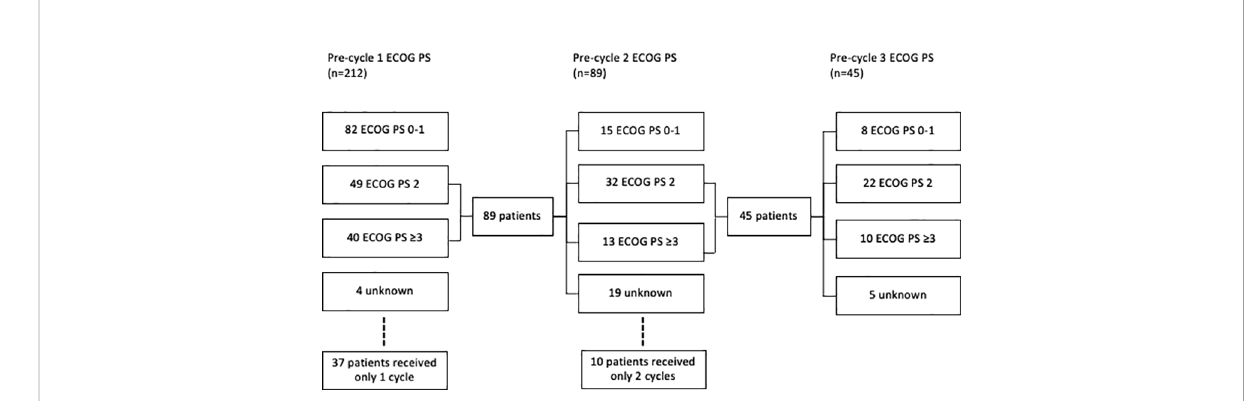
FIGURE 2 Consort diagram of ECOG of small cell lung cancer patients treated with platinum doublet prior to cycle 1, 2, and